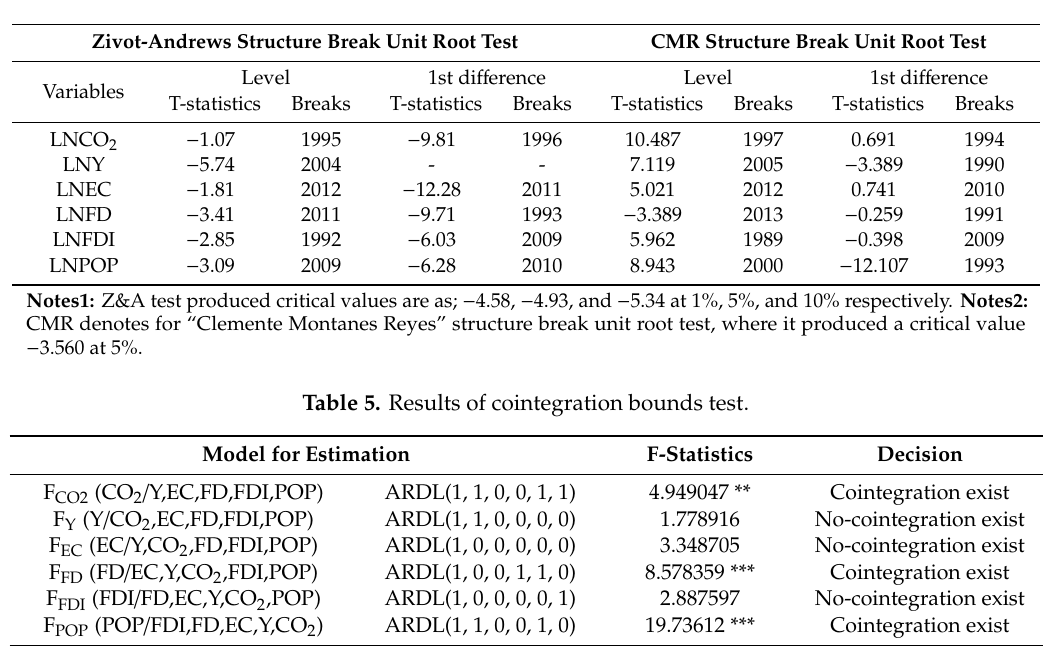
Table 4. Results of Zivot-Andrews and CMR structure break unit root tests.